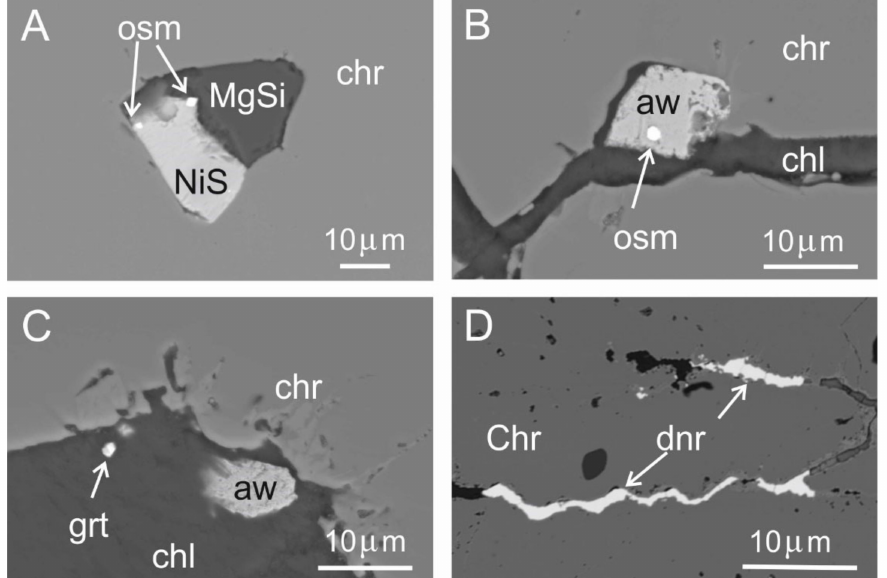
Figure 14. BSE images of primary PGM inclusions in chromite from the deposits of Kraka. Native Os + millerite + serpentine, sample PE1759 ( A ); native Os + awaruite ( B ); garutiite + Ni-arsenide in the altered chlorite matrix, sample PE1755 ( C ); dienerite filling fissures in chromite, sample PE1755 ( D ). Abbreviations: osm = native osmium; chr = chromite; MgSi = serpentine; chl = chlorite; aw = awaruite; grt = garutiite; dnr =